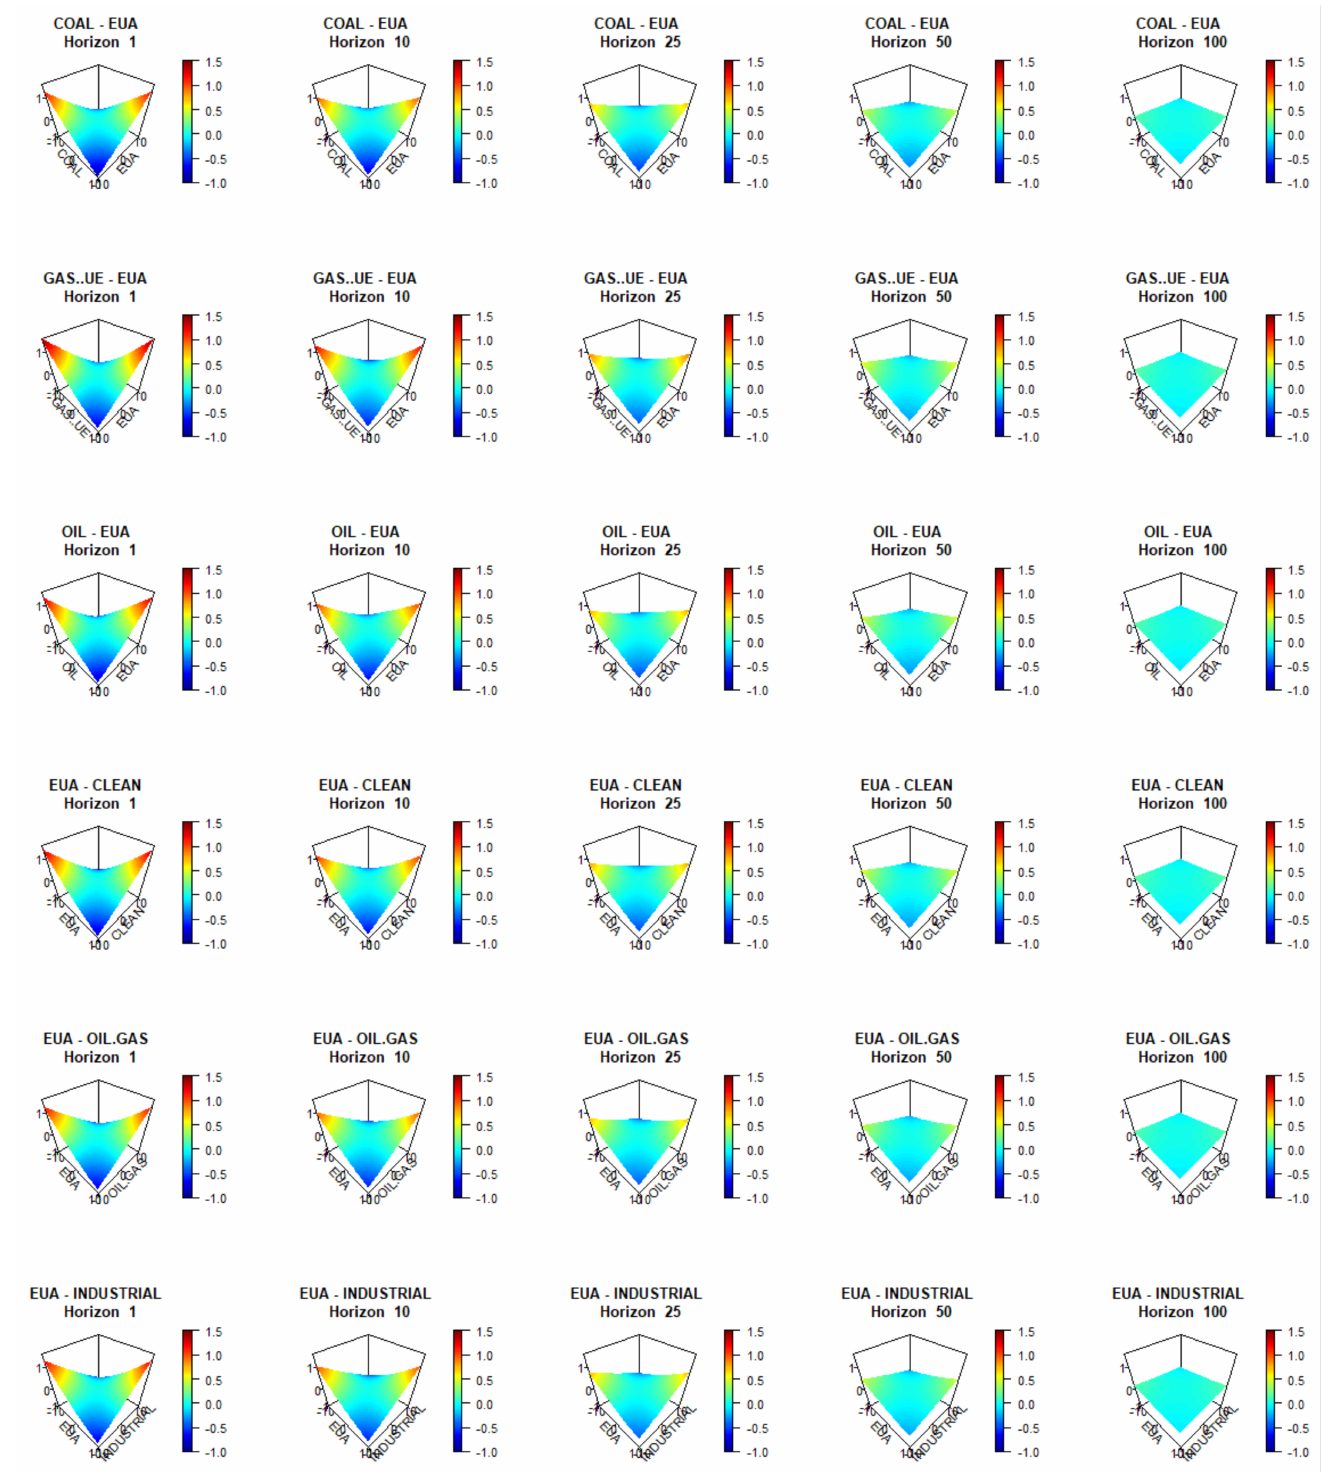
Figure 15. Matrix graph with the dynamic evolution of response surfaces of the conditional correlation between each variable and EUA to bivariate impulses of different size on themselves. Each row corresponds to each pair of variables and each column to a temporal